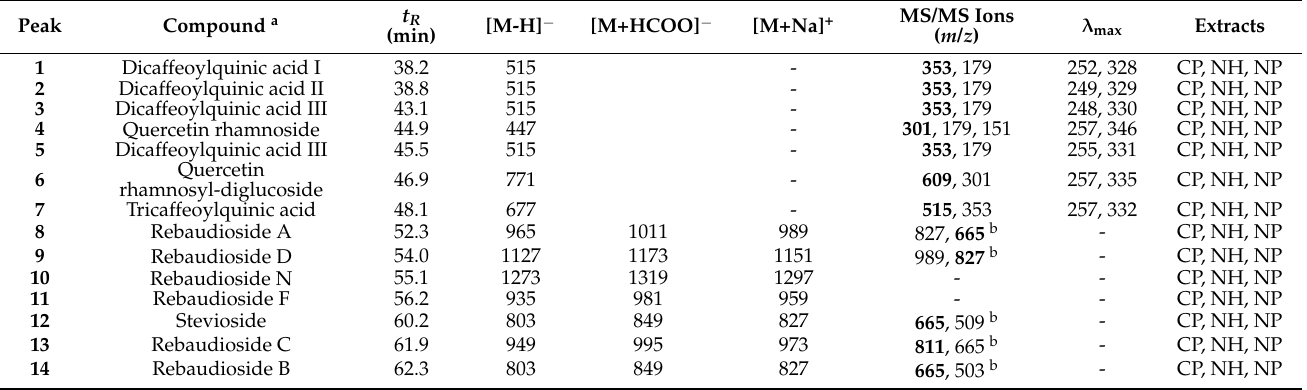
Table 3. Chromatographic ( t R , retention time), UV ( λ max , wavelength of maximunm absorbance), and full/fragmentation mass spectrometry data (MS and MS/MS) of compounds detected in the methanolic extracts of Stevia rebaudiana using HPLC-PDA-ESI-MS analyses. The peak numbers correspond to those of Figure 3.